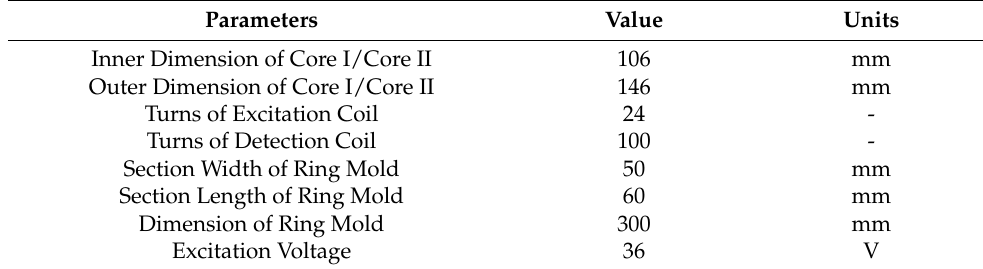
Table 1. The main structural dimensions and coil parameters.